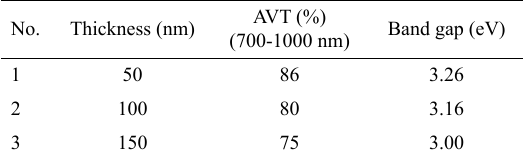
O films 2 3 O thin films with different 2 3